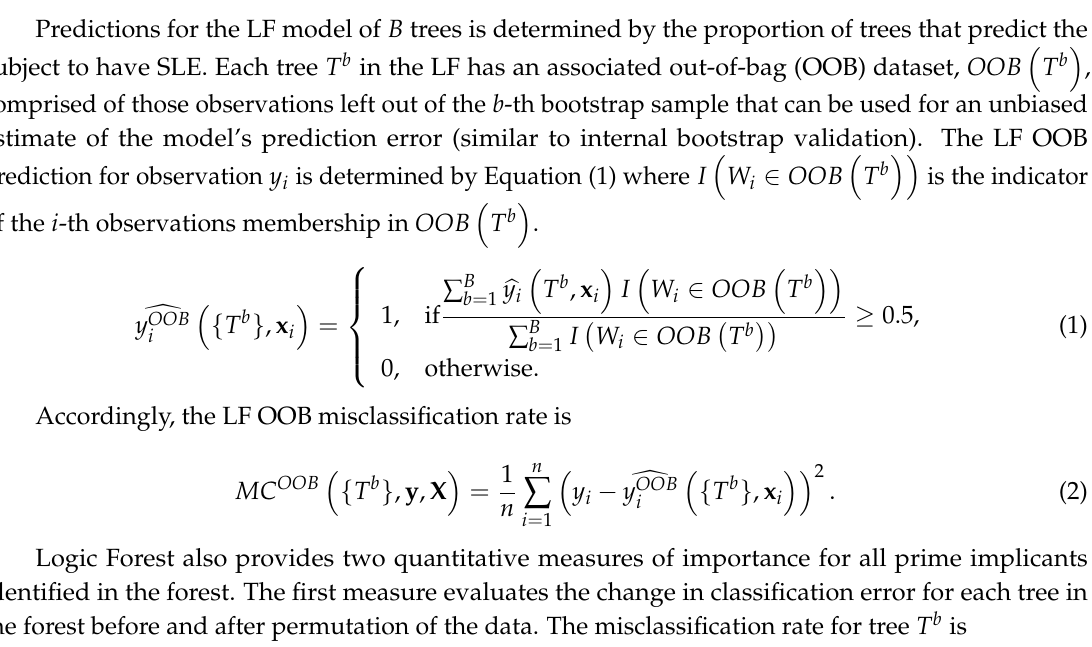
Figure 2. Example of a logic regression tree. White boxes represent the predictor, in the case of SNPs, the recessive effect of the minor allele, and black boxes represent the complement of that predictor (e.g., for a SNP, this means the dominant effect of the major allele). There are three independent predictors/predictor interactions identified within the tree: (1) exposure to passive smoking as a child and having at least one copy of the major allele of rs2359661 (A) in ITGAM ; (2) having two copies of the minor allele of rs4632147 (T) in ITGAX ; and (3) having two copies of the minor allele of rs11761199 (G) in IRF5